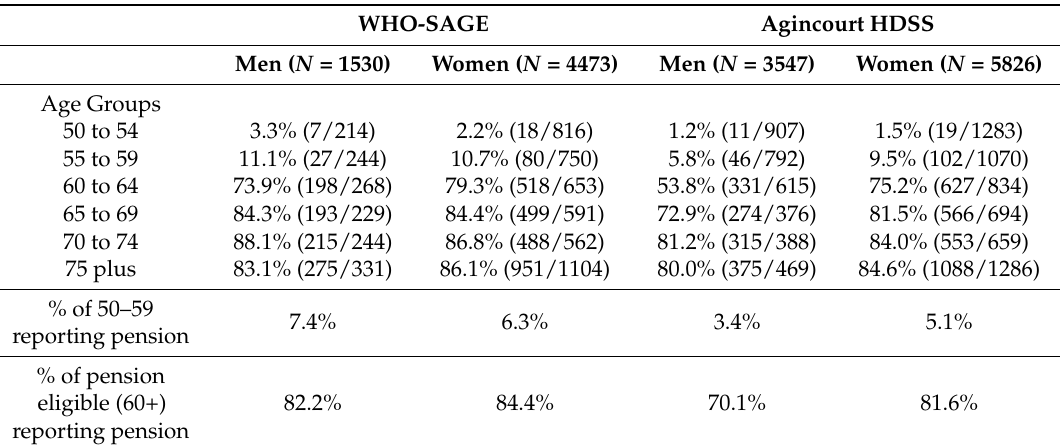
Table 1. Percent reporting pension receipt by sex and 5-year age group, Agincourt HDSS and WHO-SAGE 2010; % ( N